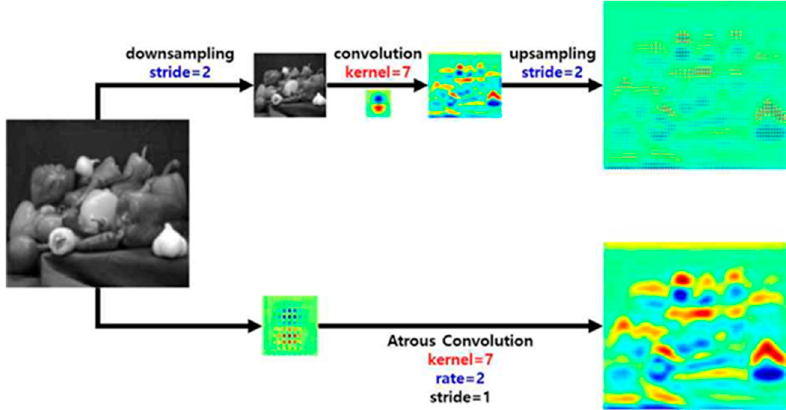
Figure 6. Comparison of semantic segmentation between general convolution and atrous convolution.